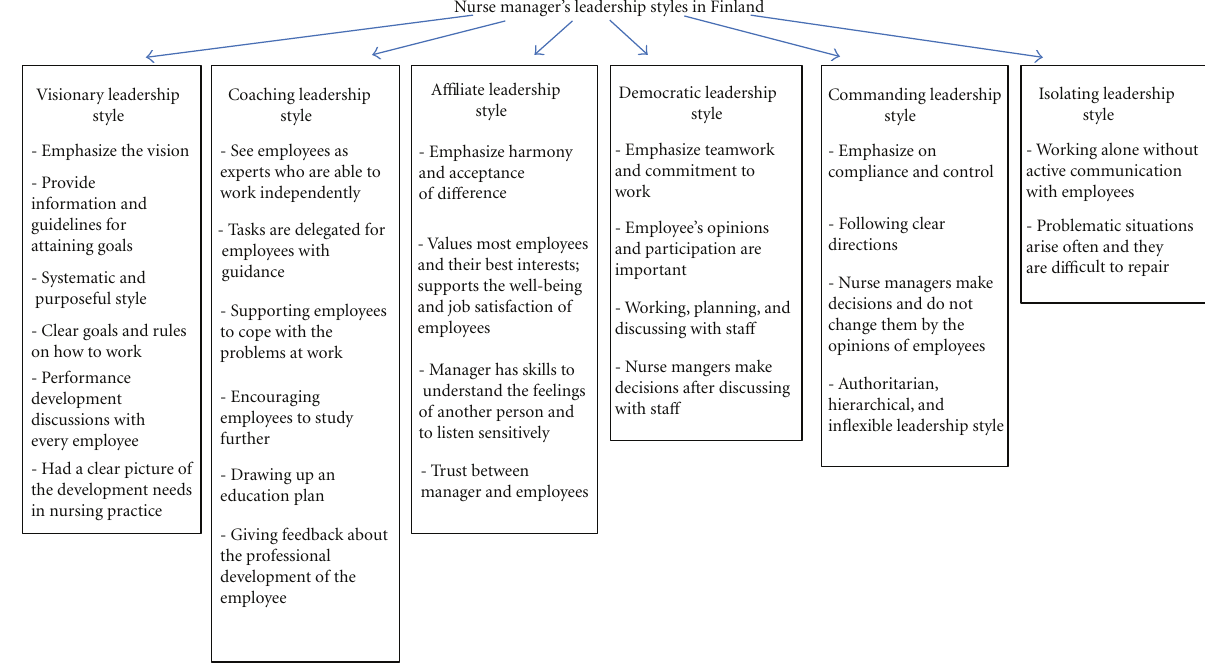
Figure 1: Nurse managers’ leadership styles in Finland. Summary of findings of the